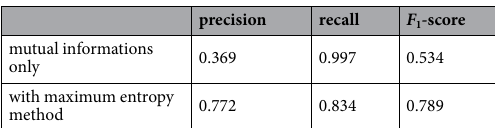
precision recall F 1 -score mutual informations only with maximum entropy method Table 1. Performance of local thresholding averaged over 100 realizations with T = 10,000 and p = 90% using 100 surrogates each. The CMI achieved a higher F 1 -score in all but 3 cases. The average difference in performance was Δ